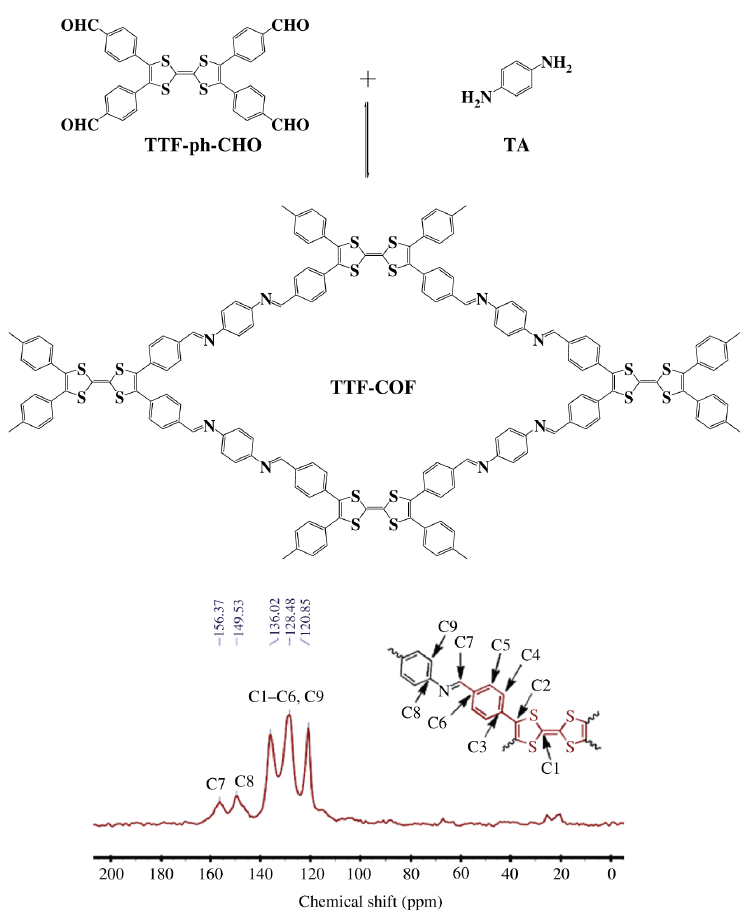
Figure 6: The synthesis 13 C and CP TOSS NMR spectrum of TTF-COF. The resonance for the carbon of the C=N bond at 157 ppm was detected by 13 C cross-polarization with total suppression of sideband NMR spectroscopic methods (Ding et al. 2014), and the expected TTF-COF was